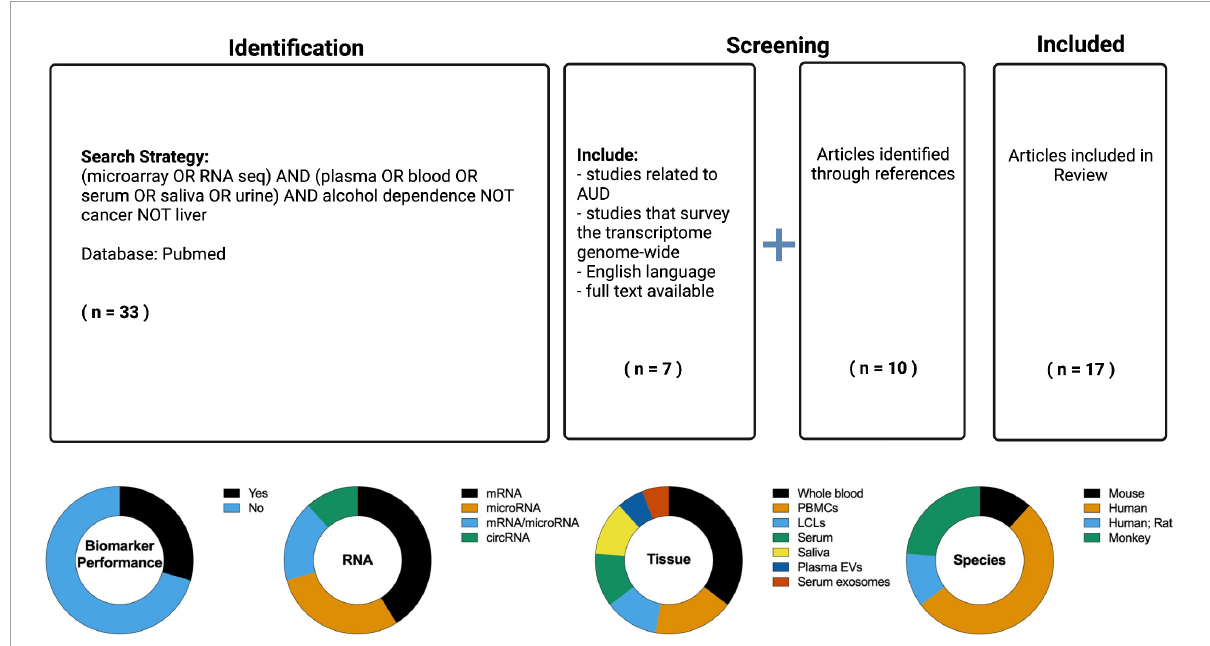
FIGURE2 (Top) PubMed was searched (inception through 2 July 2022) for relevant literature using a Boolean search strategy. The articles were evaluated for the following inclusion characteristics: English language, full text availability, related to alcohol use disorder (the search results contained many studies related to liver diseases and carcinomas which were excluded), non-targeted study with multiple biomarkers evaluated, some metric of biomarker utility (e.g., accuracy, area under the receiver operating characteristic curve). References from articles in the search were also considered for inclusion in the Review. The resulting information from these searches was reviewed to provide an overview of the current knowledge regarding RNA based biomarkers in alcohol use disorder (AUD). (Bottom) Overview of the RNA biomarker studies identified in the literature search. The seventeen studies identified were classified by the following attributes: performance metric, RNA type, tissue sampled, and